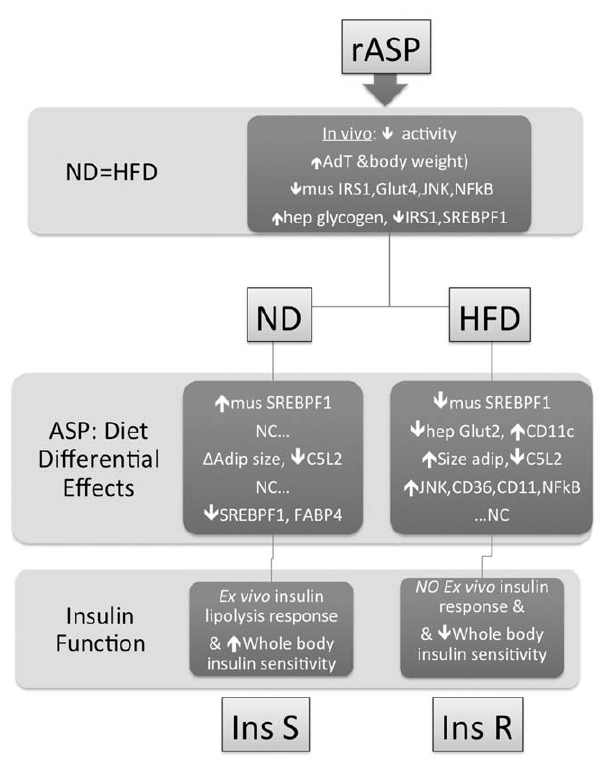
Figure 7. Diagram of low fat diet and high fat diet induced interactions with rASP administration. Recombinant ASP admin- istration induced changes in adipose tissue (AdT), muscle (mus) and liver (hep) that, in some cases, were identical in both diets (ND=HFD panel). On the other hand, there were many differential changes according to the diet (normal low fat diet, ND, vs high fat diet, HFD) as outlined in the ASP: Diet Differential Effects panel. As a consequence, rASP administration led to enhanced insulin sensitivity in ND, but led to greater insulin resistance in HFD (Insulin Function panel), where NC=no